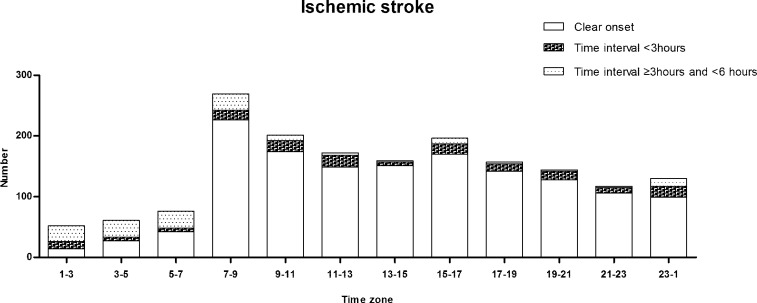
Distribution of time-specific IS with clear onset and unclear onset ranges from 0–3 h and 3–6 h, all assigned within 2-hour intervals.